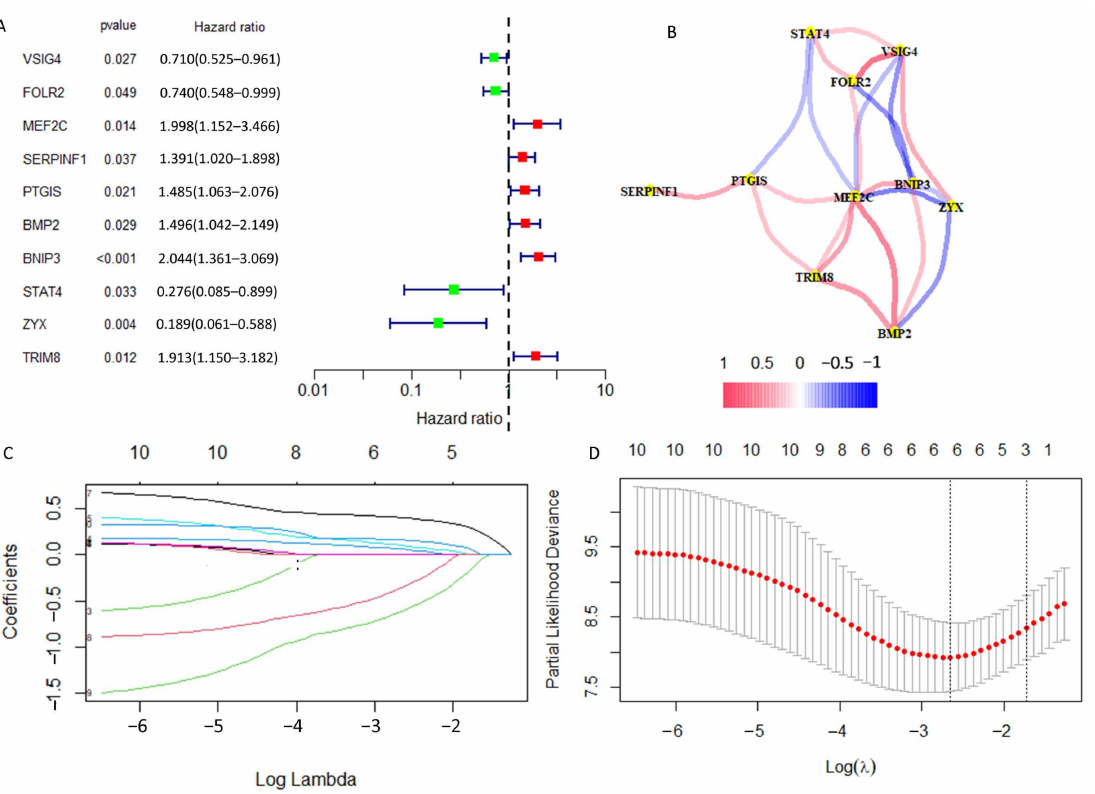
Figure 2. Obtaining DRGs associated with osteosarcoma prognosis. ( A ) Univariate Cox regression analysis for identifying prognostic DRGs. ( B ) Interaction network diagram of prognosis-related DRGs. ( C , D ) Lasso–Cox regression analysis was performed to construct prognostic prediction